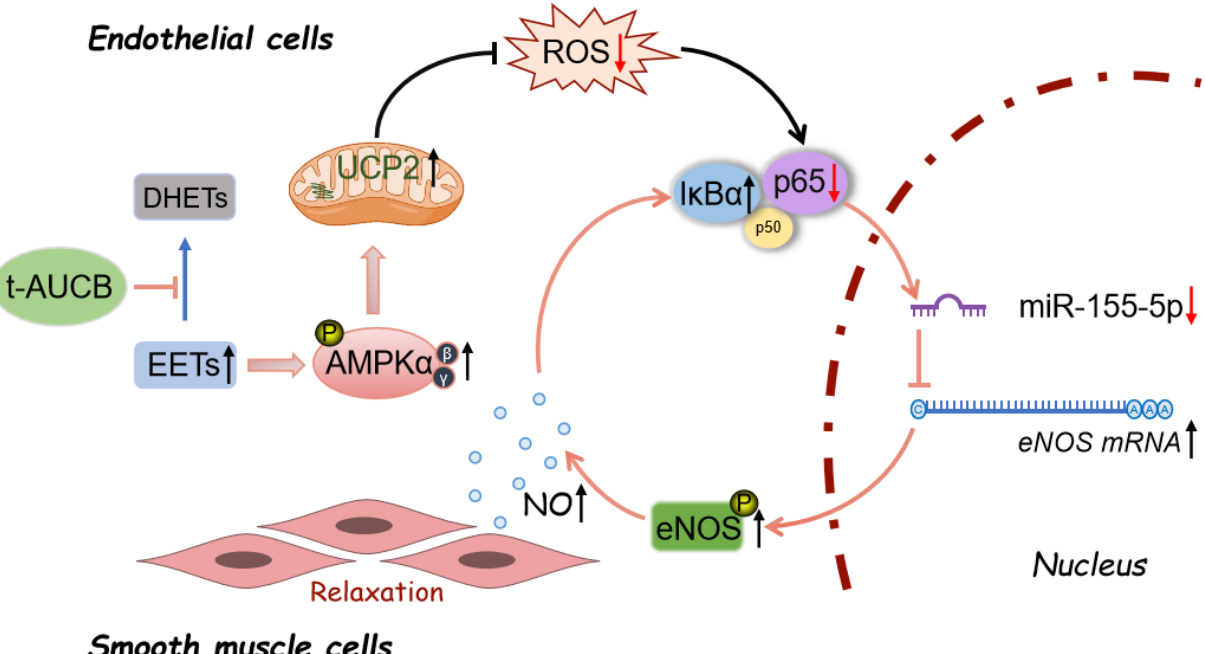
Figure 8. The proposed molecular mechanism for the protective effect of t-AUCB against endothelial dysfunction in hypertension. t-AUCB decreased the degradation of EETs and, thus, increased their levels. EETs stimulated AMPK/UCP2 activation, suppressed mitochondrial ROS production, and regulated an NF- κ B/miR-155-5p/eNOS/NO/I κ B cycle, thereby improving endothelial function in 2K1C hypertensive rat renal arteries.